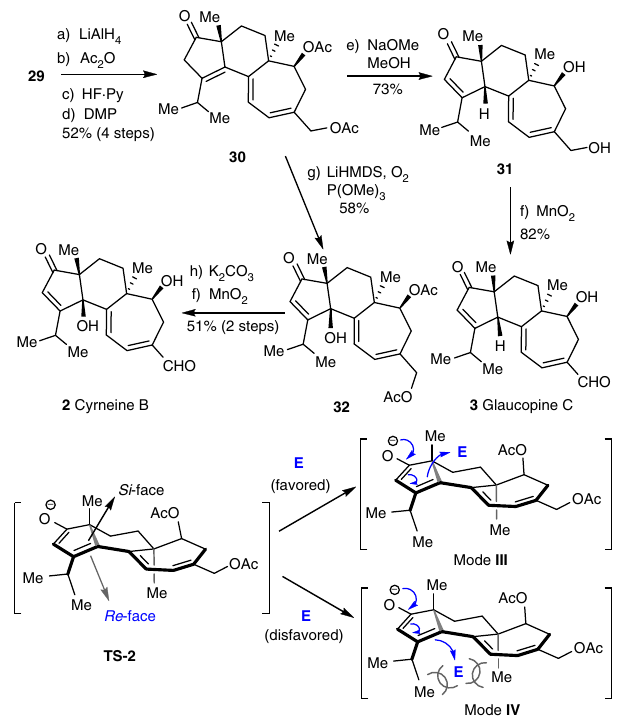
Fig. 6 The synthesis of cyrneine B and glaucopine C. Reagents